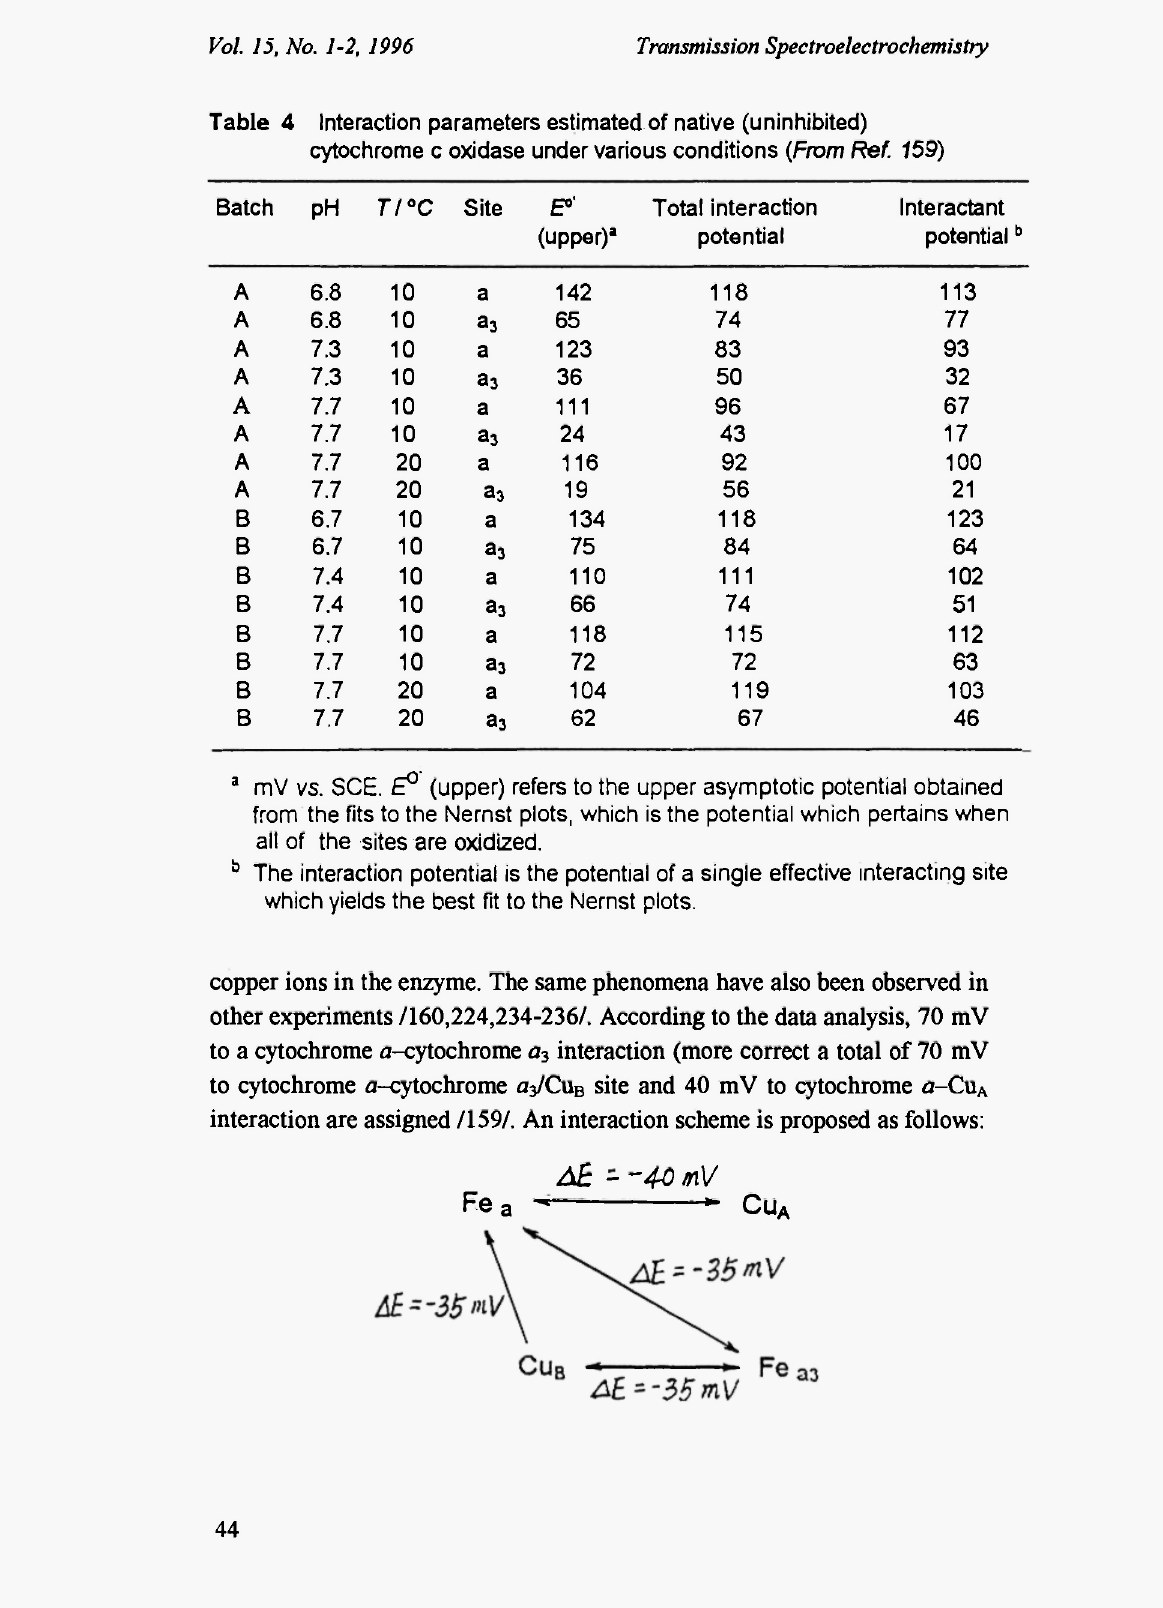
Interaction parameters estimated of native (uninhibited) cytochrome c oxidase under various conditions ( From Ref. 159) Batch pH r / °c Site E 0 ' Total interaction Interactant (upper)" potential potential